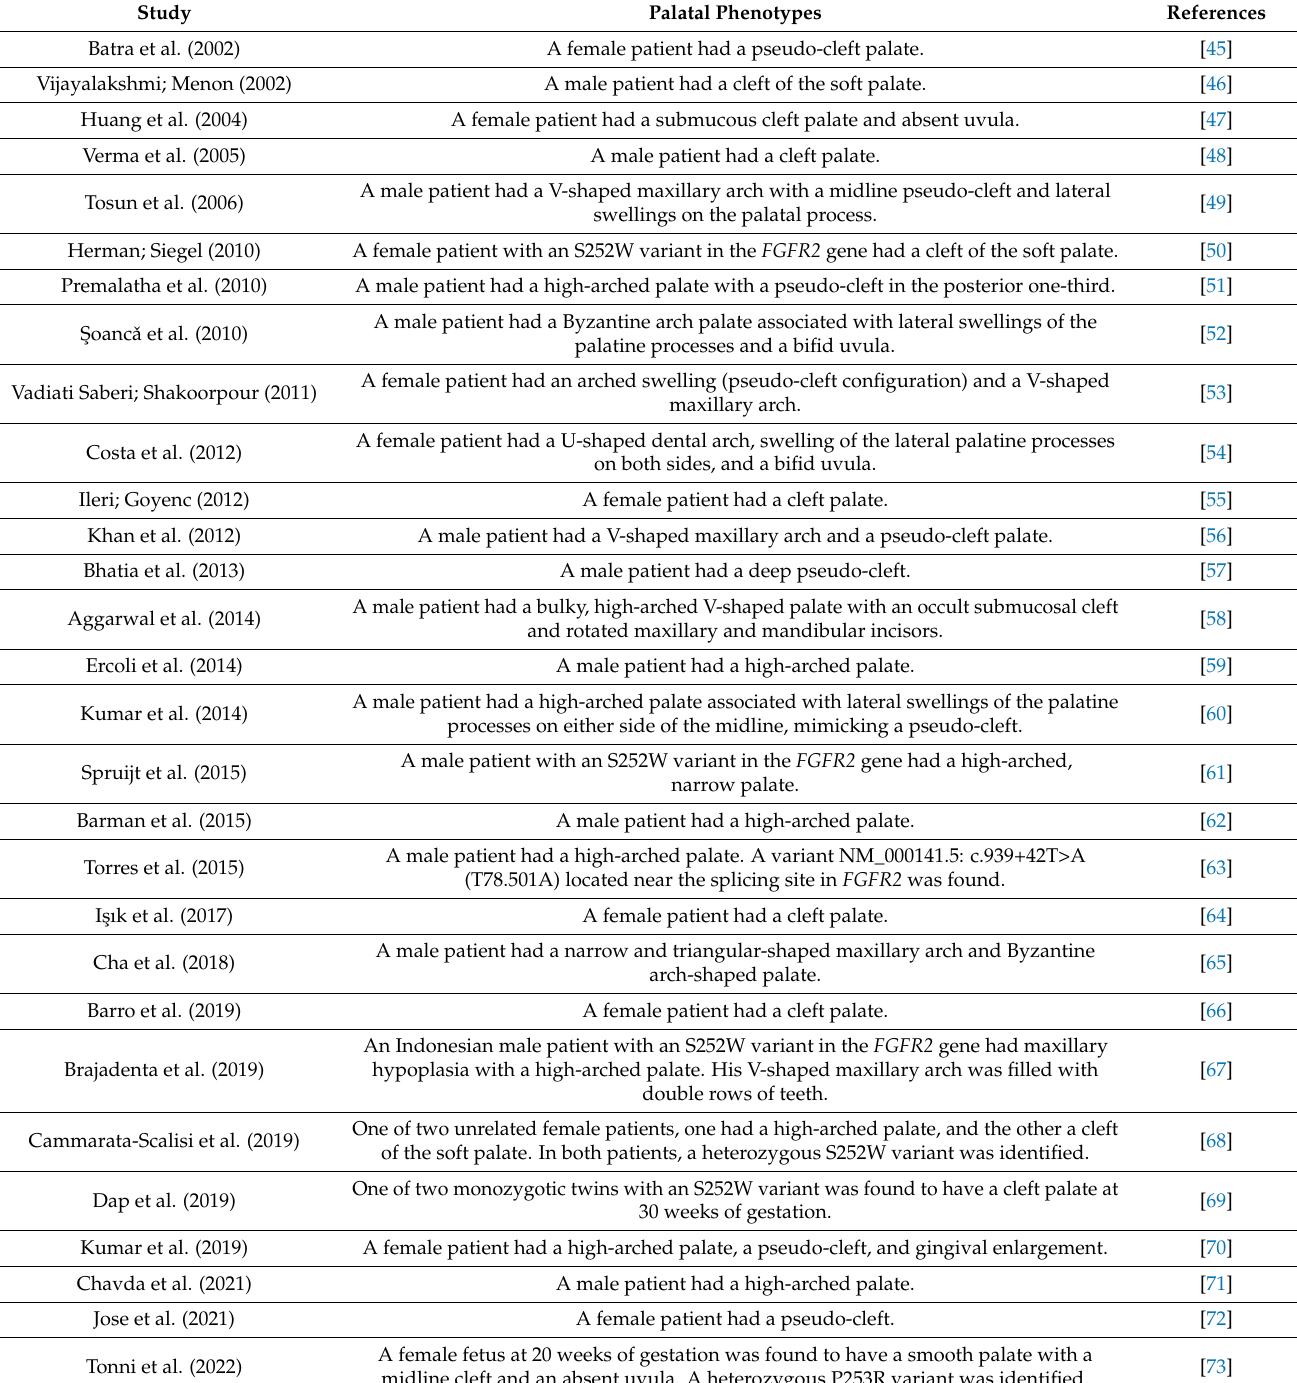
Table 2. Palatal phenotypes in case reports of Apert